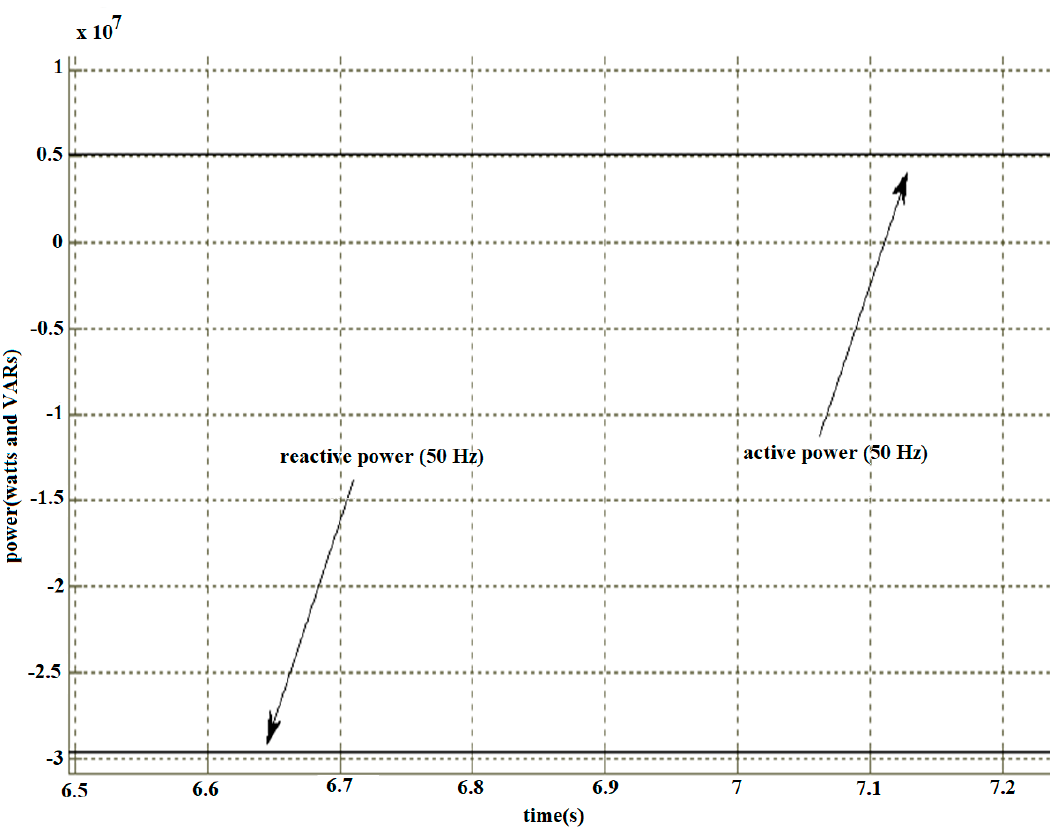
Figure 32. Active and reactive power at S16 (50 Hz).